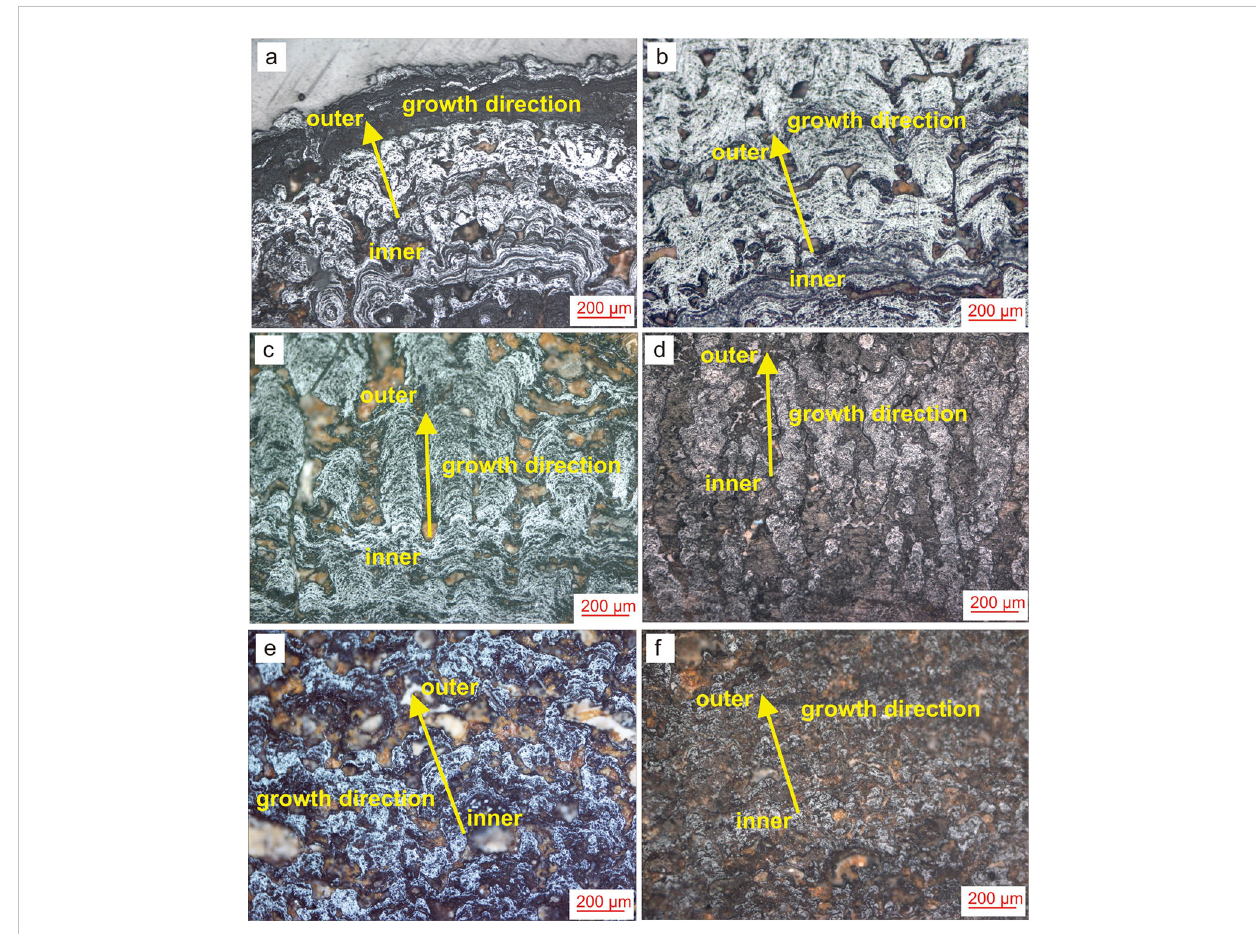
FIGURE 2 Photos of main growth structure of the SCS polymetallic crusts and nodules (A, B) laminated structure, (C, D) columnar, structure, (E, F) taxitic